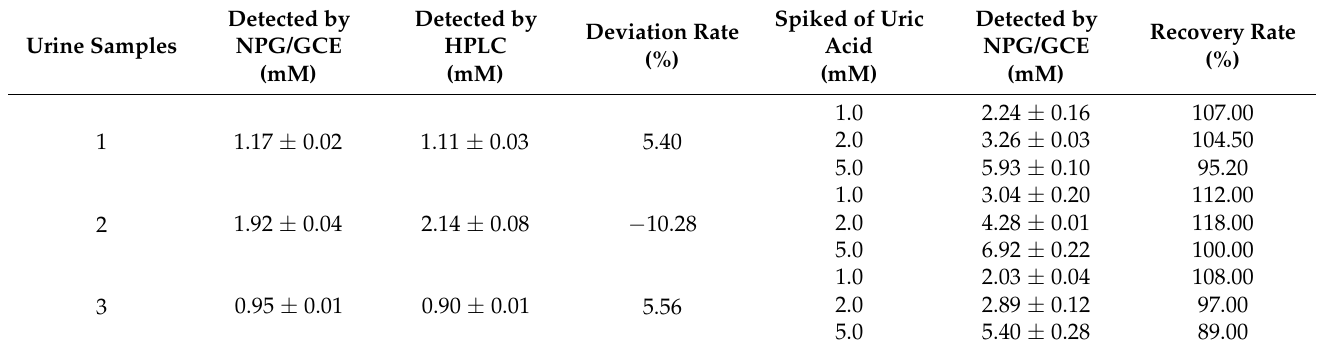
Table 1. The detection of uric acid in human urine samples.